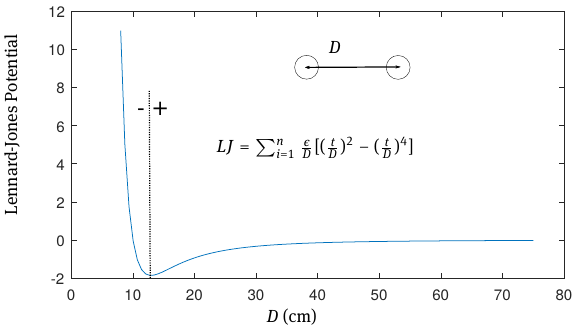
Figure 3: The Lennard-Jones potential adapted for wheeled robots formation. The ’-’ and ’+’ domains are respectively the repulsive and attractive parts, for which the pivot point is set with parameter t . D is the distance between two robots and ϵ a parameter acting as a control gain on the